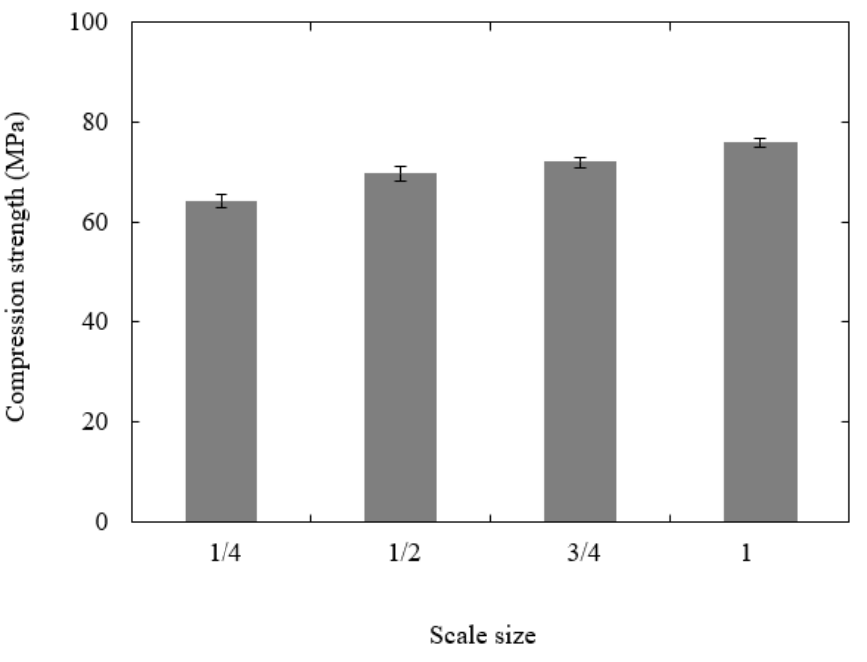
Figure 6. Plot of compression strength vs. scale size for the PLA cubes.